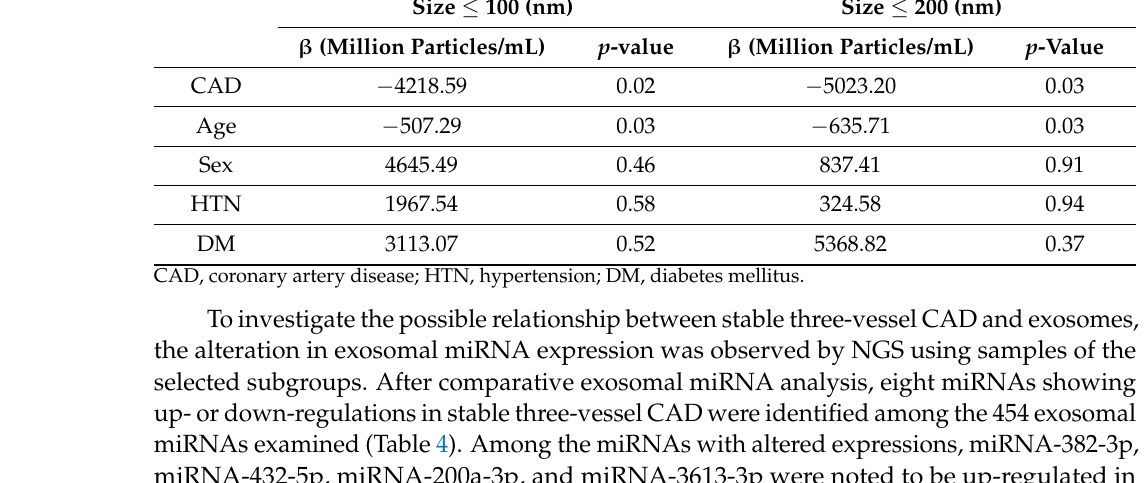
Table 3. Multiple linear regression for the amounts of exosomes from the total population. Size ≤ 100 (nm)